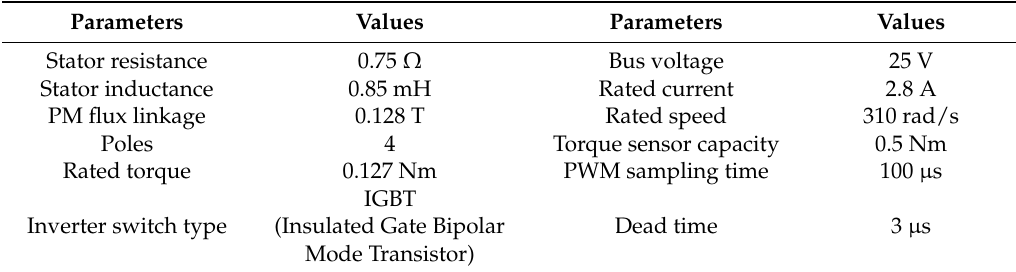
Table 1. Parameters of SPMSM drive.